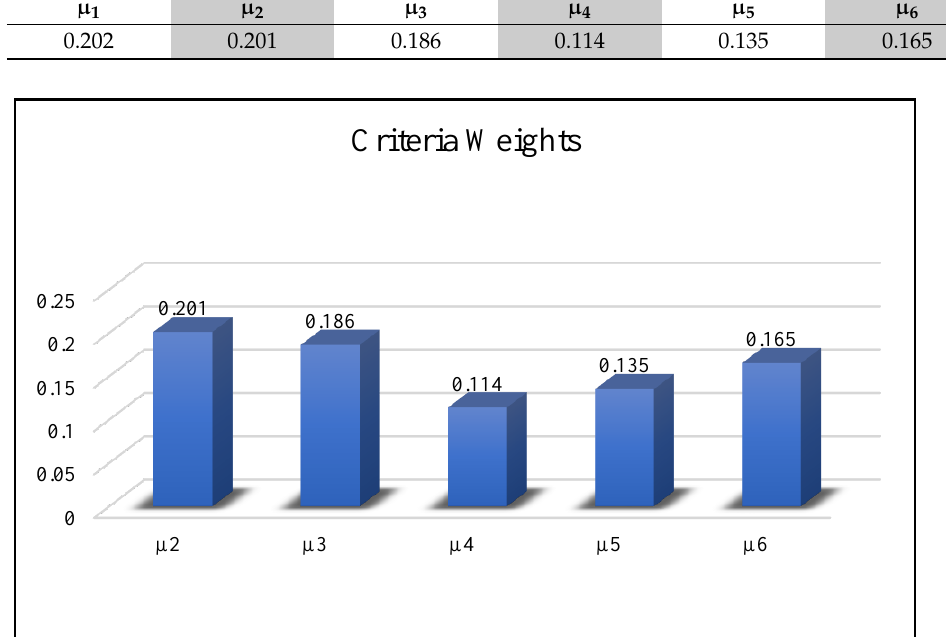
Table 8. Aggregated weights of criteria.